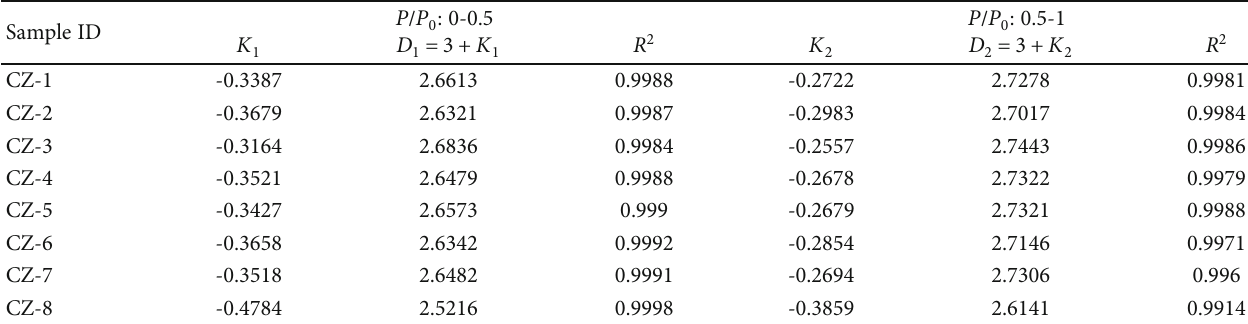
Figure 7: Fractal fi tting curves of the Lujiaping shale. Table 3: Fractal dimensions of the Lujiaping